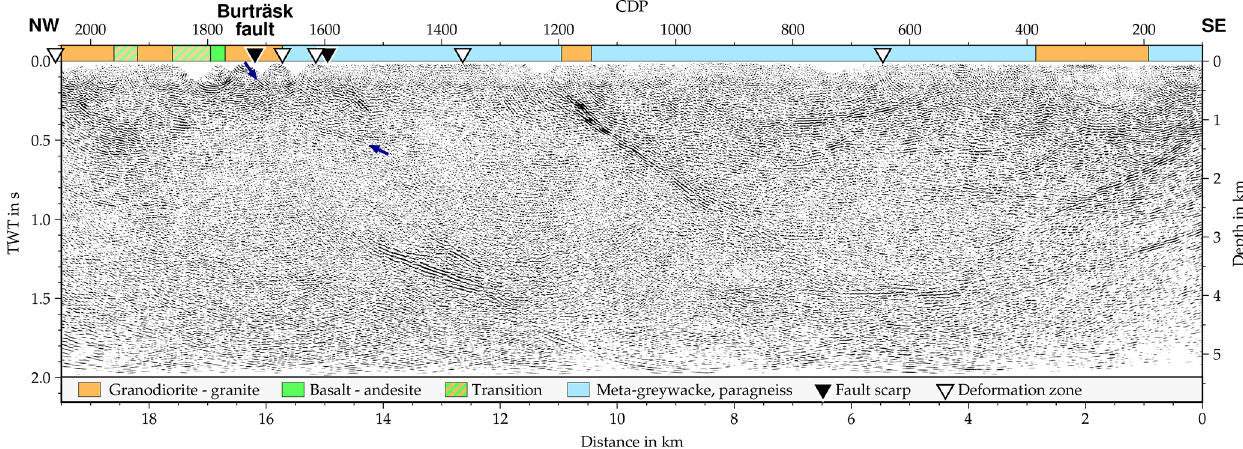
Figure 13. Migrated section along the Buträsk profile. For comparison, the surface geology is plotted on top of the section and the location of the fault scarp and deformation zones are marked. The small blue arrows highlight a very weak reflection that might be associated with the fault scarp. The vertical exaggeration of the section is approximately 1.